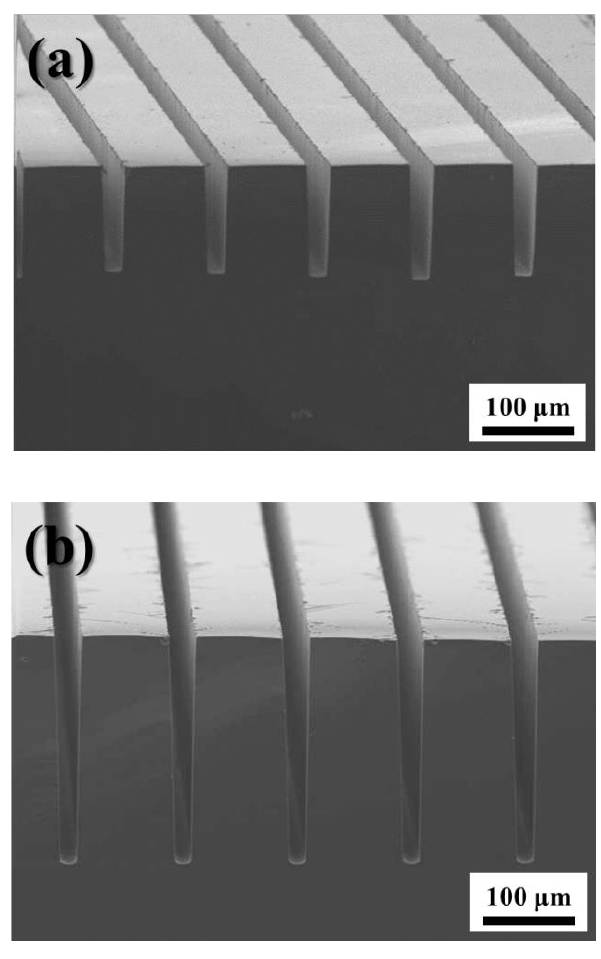
Figure 4. Cross-sectional SEM images of vertical Si groove arrays produced by magnetically guided MACE for etching durations of ( a ) 3 h and ( b ) 5 h.